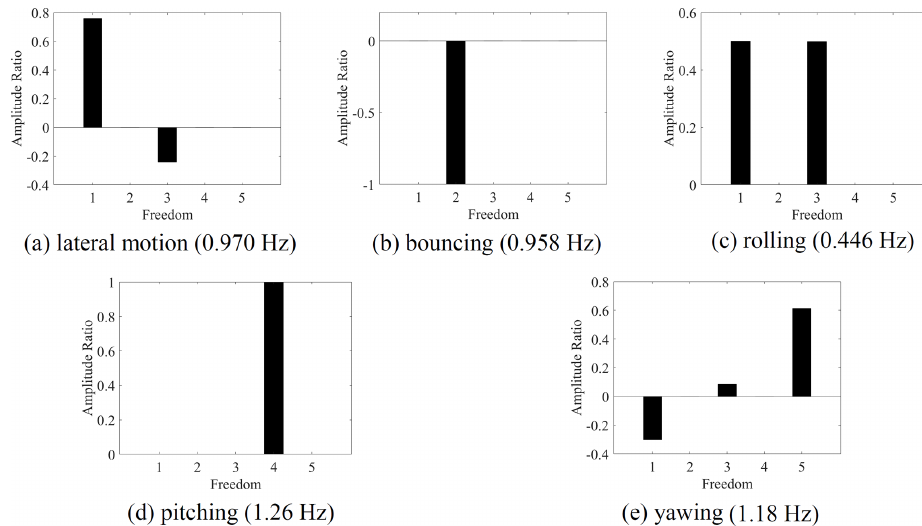
Figure 5. Vibration shapes of the car